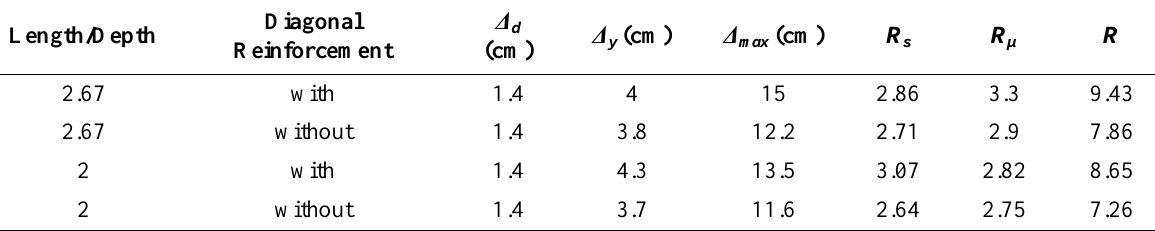
Fig. 9. Diagonal reinforcement bracing in spandrel beam Table 5. Response modification factor for 5 story structure with deep beams